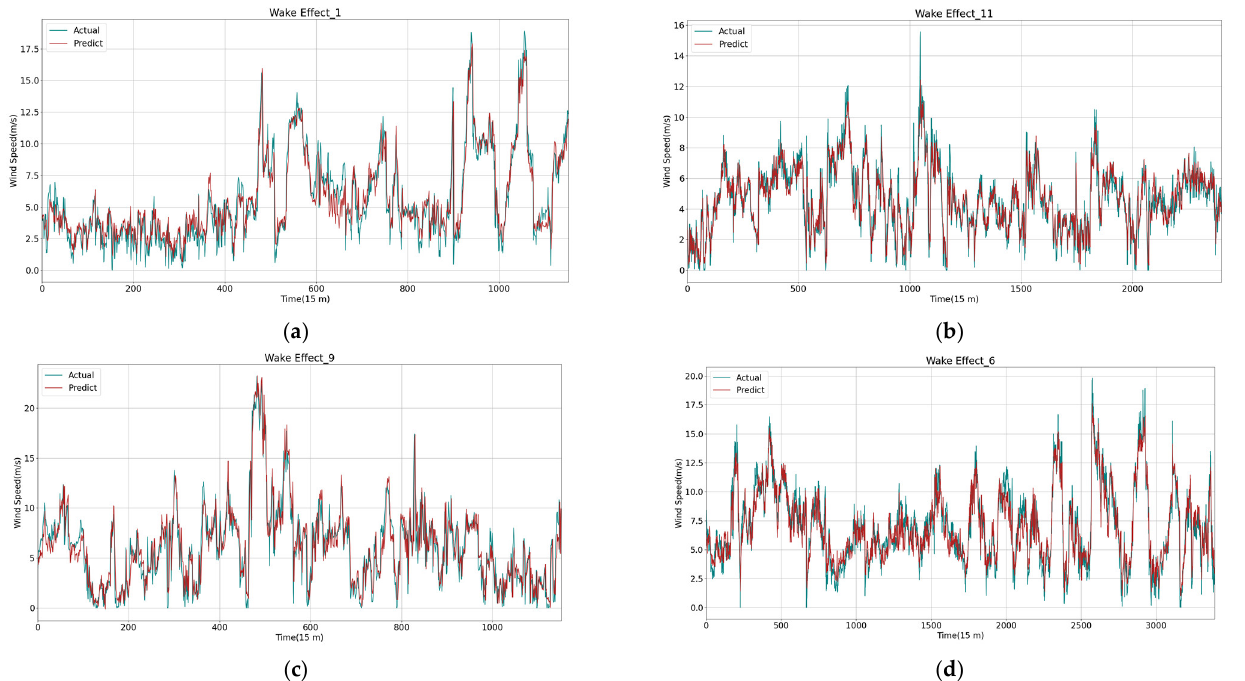
Figure 8. Wind turbines affected by wind turbine No. 5 (by direction): ( a ) prediction of wake effect for No. 1 wind turbine by machine learning (N direction); ( b ) prediction of wake effect for No. 11 wind turbine by machine learning (E direction); ( c ) prediction of wake effect for No. 9 wind turbine by machine learning (S direction); ( d ) prediction of wake effect for No. 6 wind turbine by machine learning (W direction).